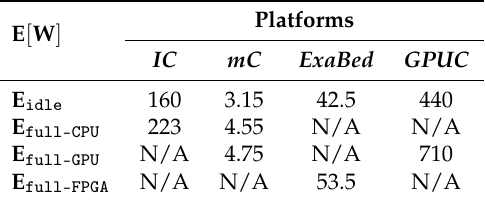
Table 3. The energy consumption of platforms. E idle is the average power over 3 min in idle of the platform; E full is the average energy used over 3 min of H Y -N BODY continuous execution with 100% load, using one CU of type either CPU, GPU, or FPGA ( E full-CPU , E full-GPU , and E full-FPGA